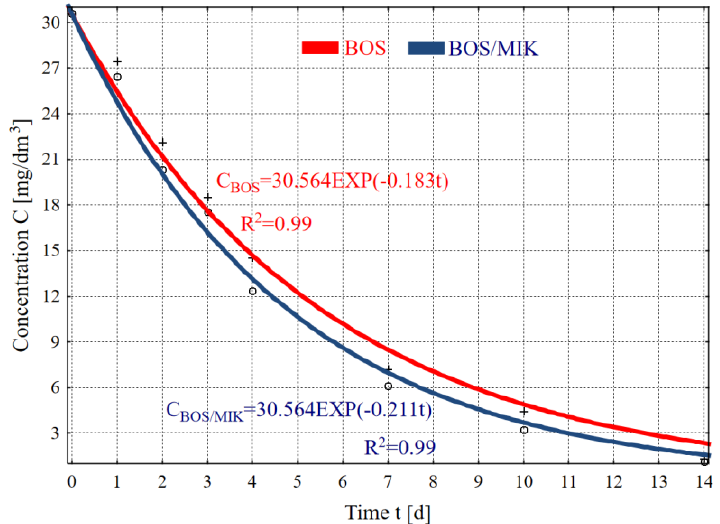
Figure 5. Boscalid disappearance dynamics curve in wastewater without microorganisms (BOS) and enriched with microorganisms (BOS/MIK) passed through a constructed wetland bed.